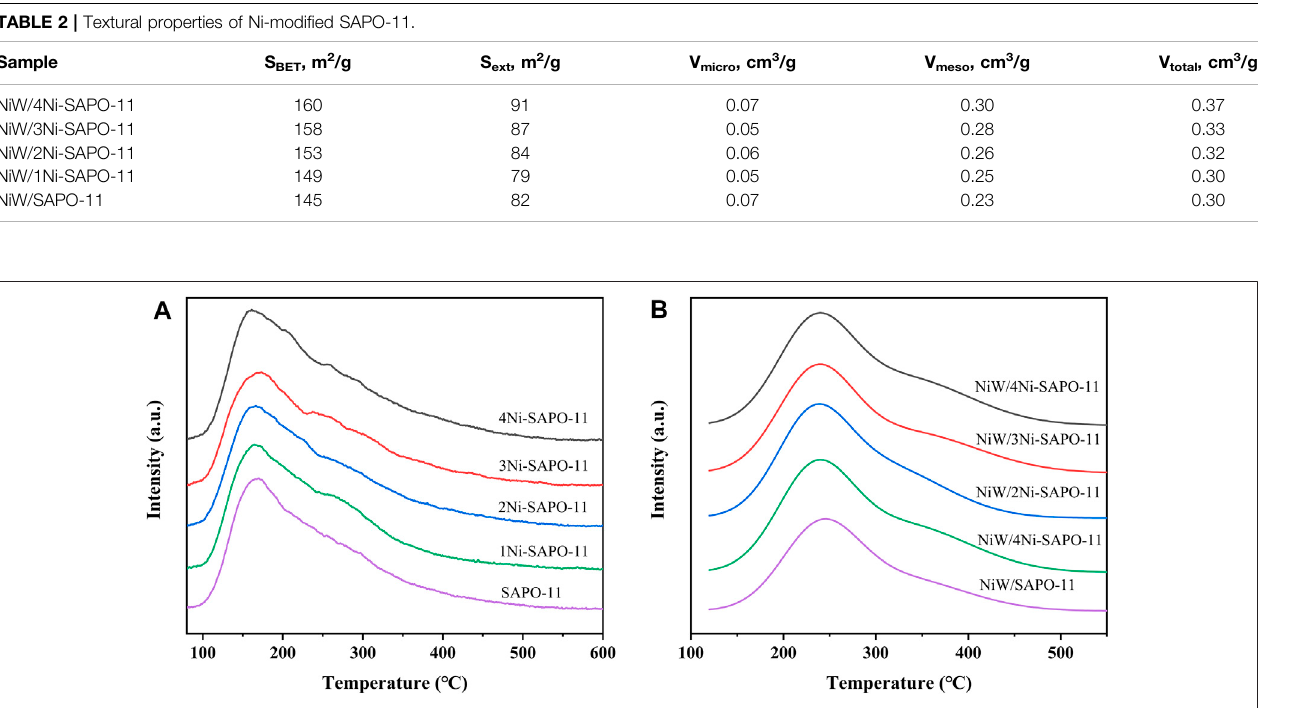
Frontiers in Chemistry |